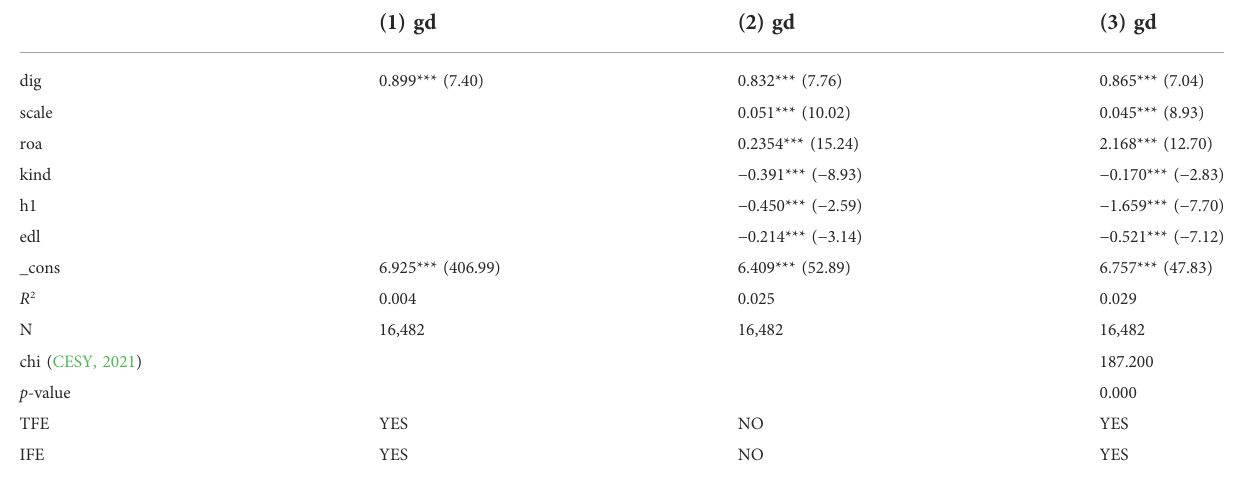
TABLE 2 Benchmark regression